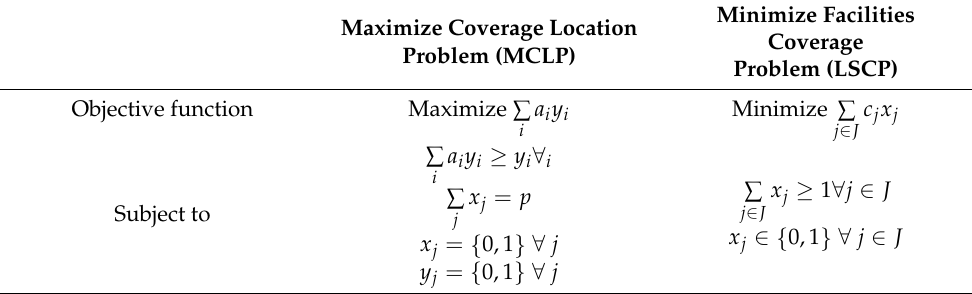
Table 4. Mathematical expressions for both L-A